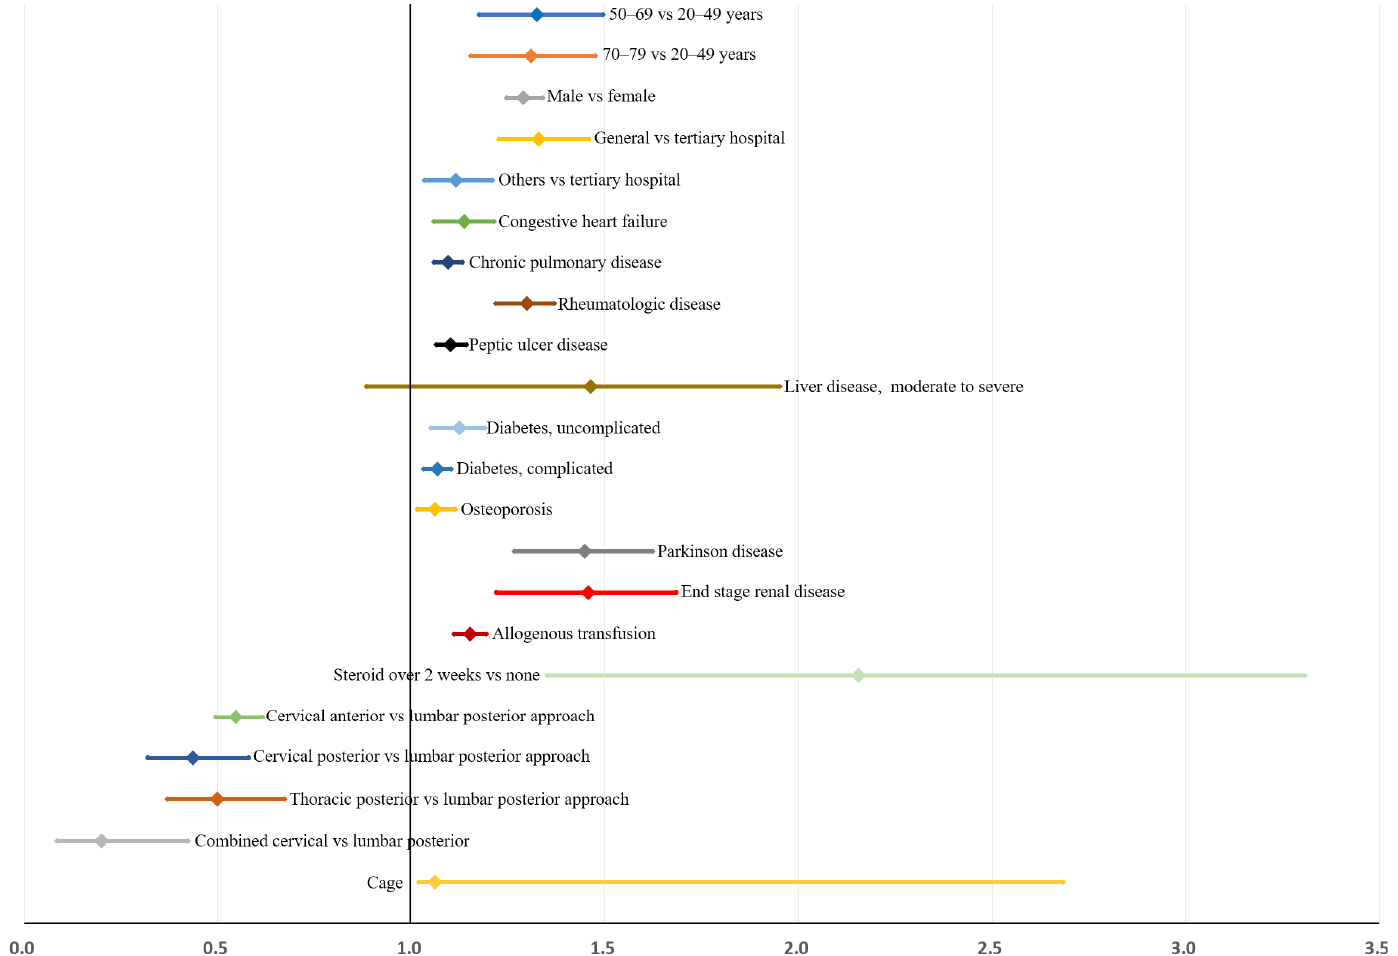
Figure 4. Risk factors for reoperation within 3 years after instrumented spinal fusion surgery for degenerative spinal disease: bootstrap-adjusted odds ratios and their 95% confidence interval (Table 5).